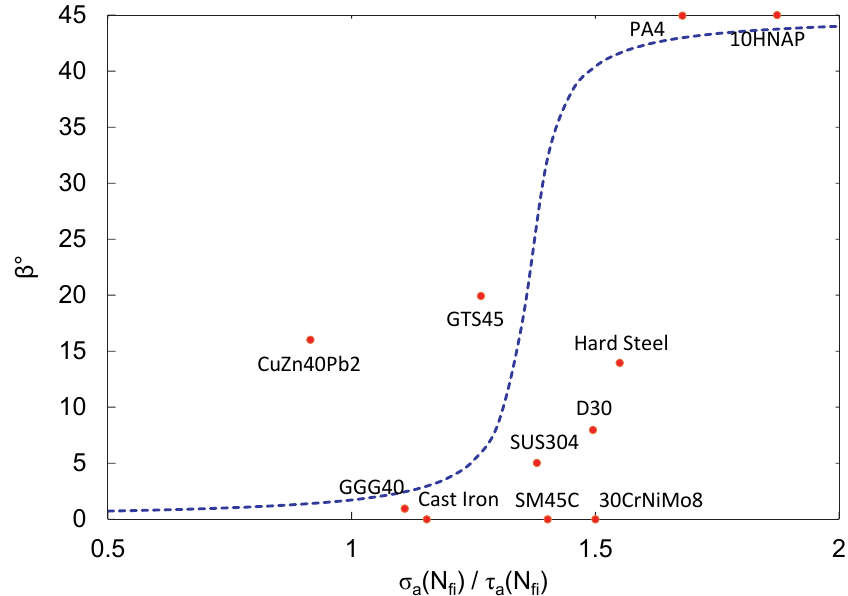
Figure 3:  against '